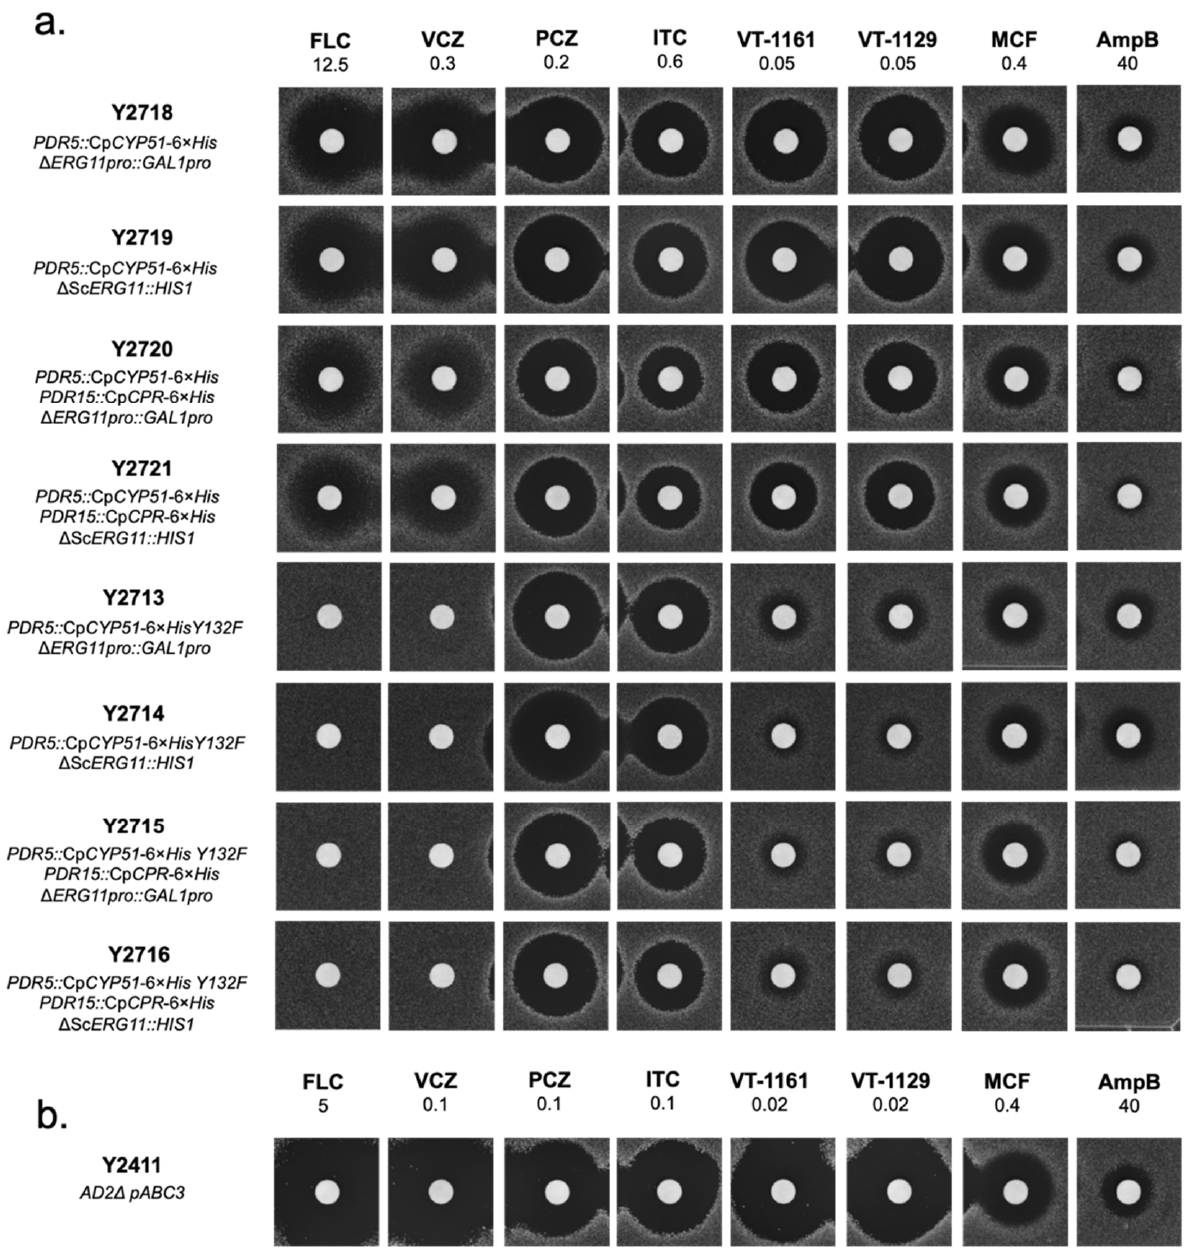
Figure 3. Agarose diffusion drug susceptibility analysis of host and recombinant strains to azole and control drugs. ( a ) Susceptibilities to antifungals of strains expressing recombinant CpCYP51 and CpCYP51 Y132F from the PDR5 loci co-expressed with CpCPR from the PDR15 loci. ( b ) Susceptibilities to the antifungals of the reference strain Y2411. The indicated amount of antifungal loaded is in nanomole per disk.